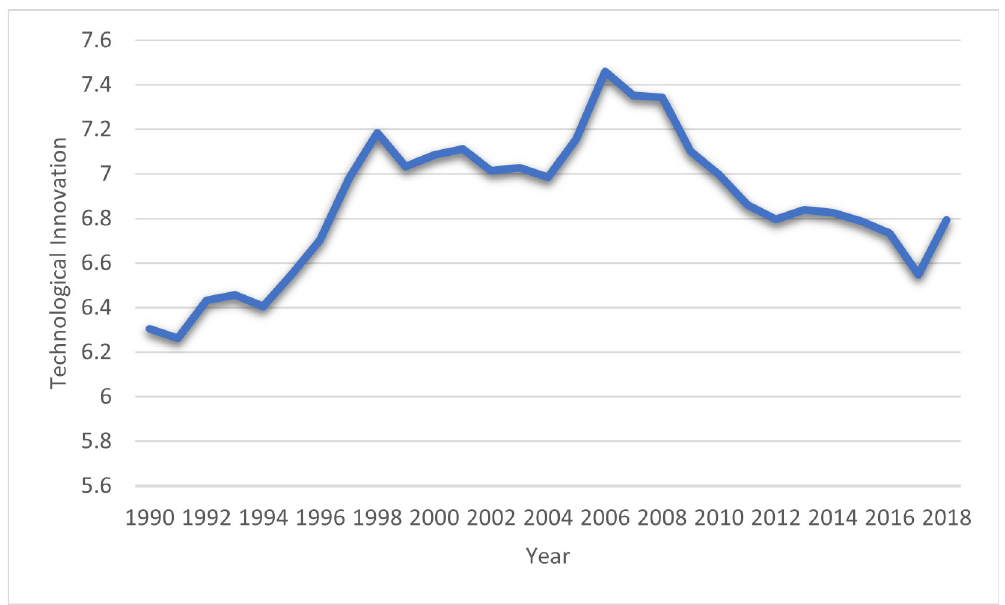
Fig 3. Technological Innovation in BRI economies: Source (World Intellectual Property